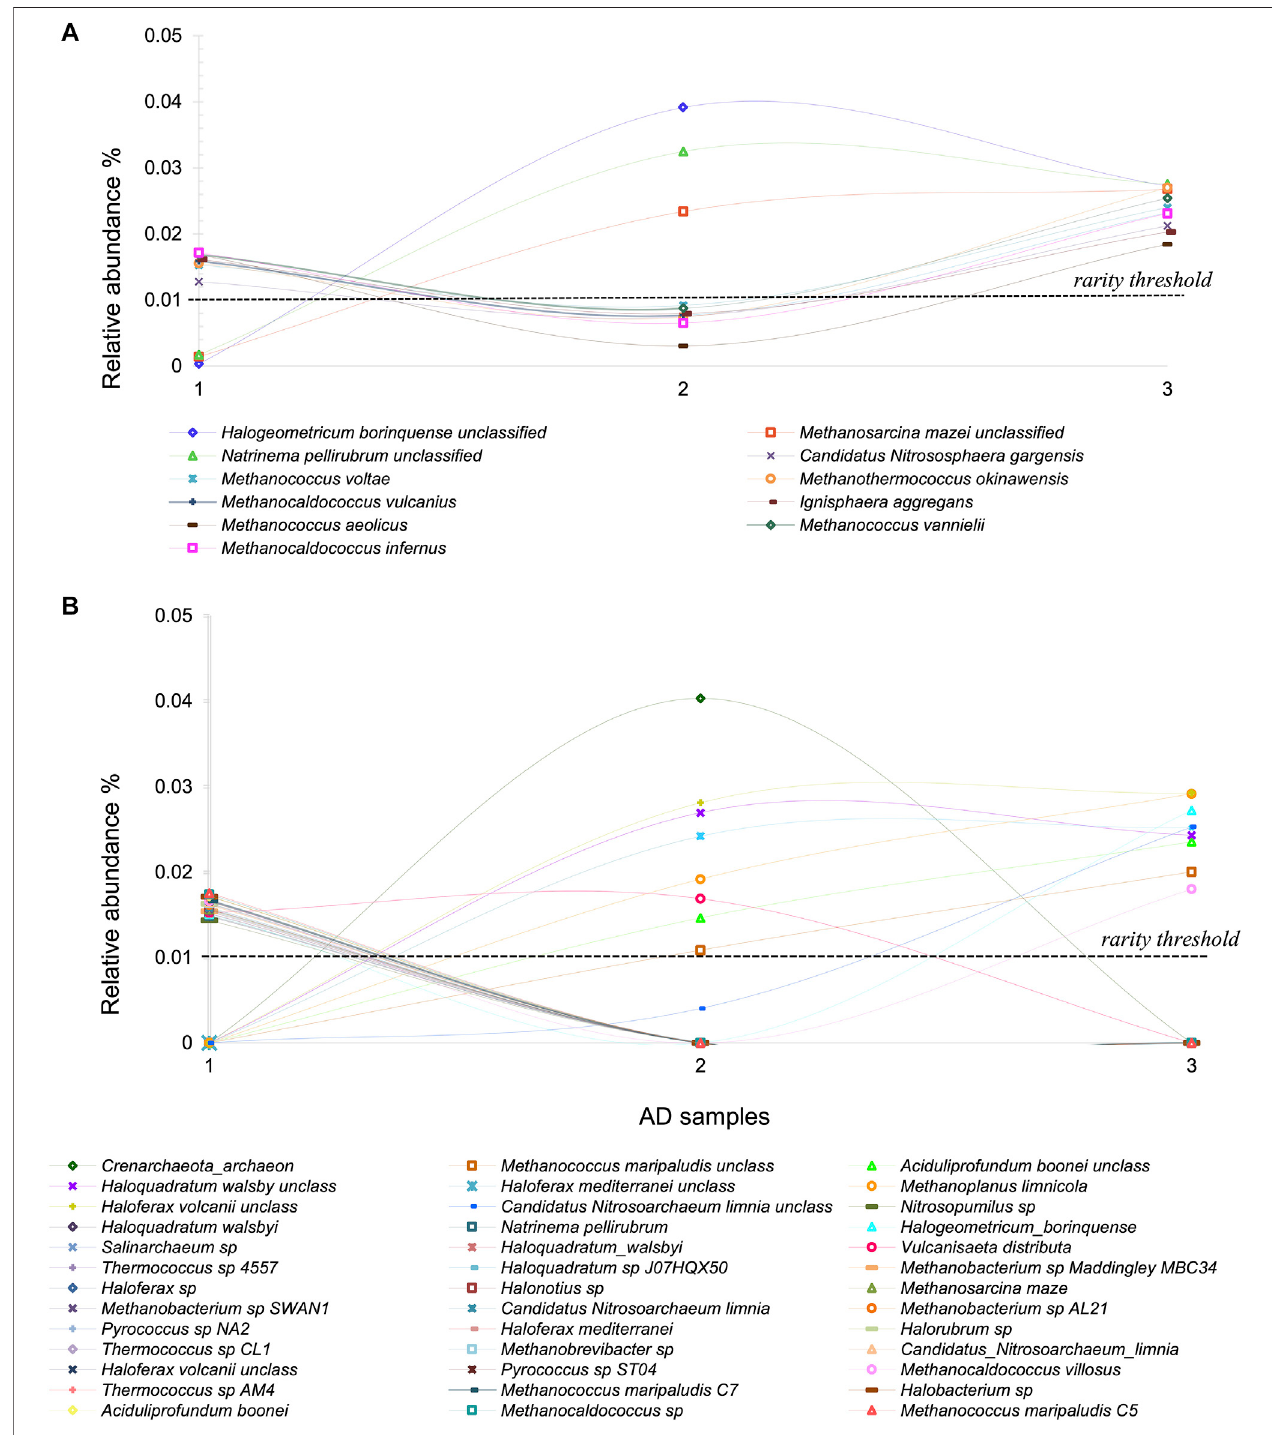
FIGURE 2 | Archaeal rare biosphere from Cuatro Cienegas Basin. (A) Conditional rare Archaea taxa in AD in a time series, typically in low abundances but incrementing his abundance and becoming dominant in some seasons (B) Transiently rare Archaea taxa in AD, which tend to appear and disappear from the environment over time.